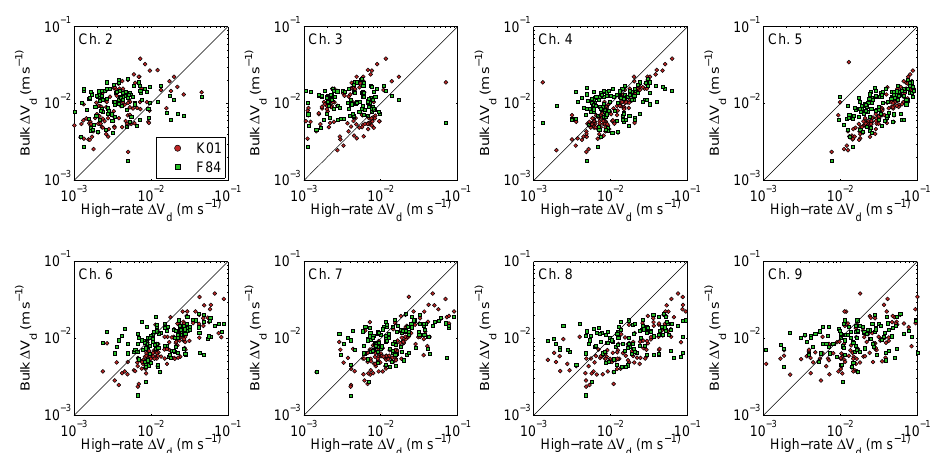
Fig. 7. Scatterplots showing the relationships between CLASP 1v d and K01/F84 1v d in Fig. 6